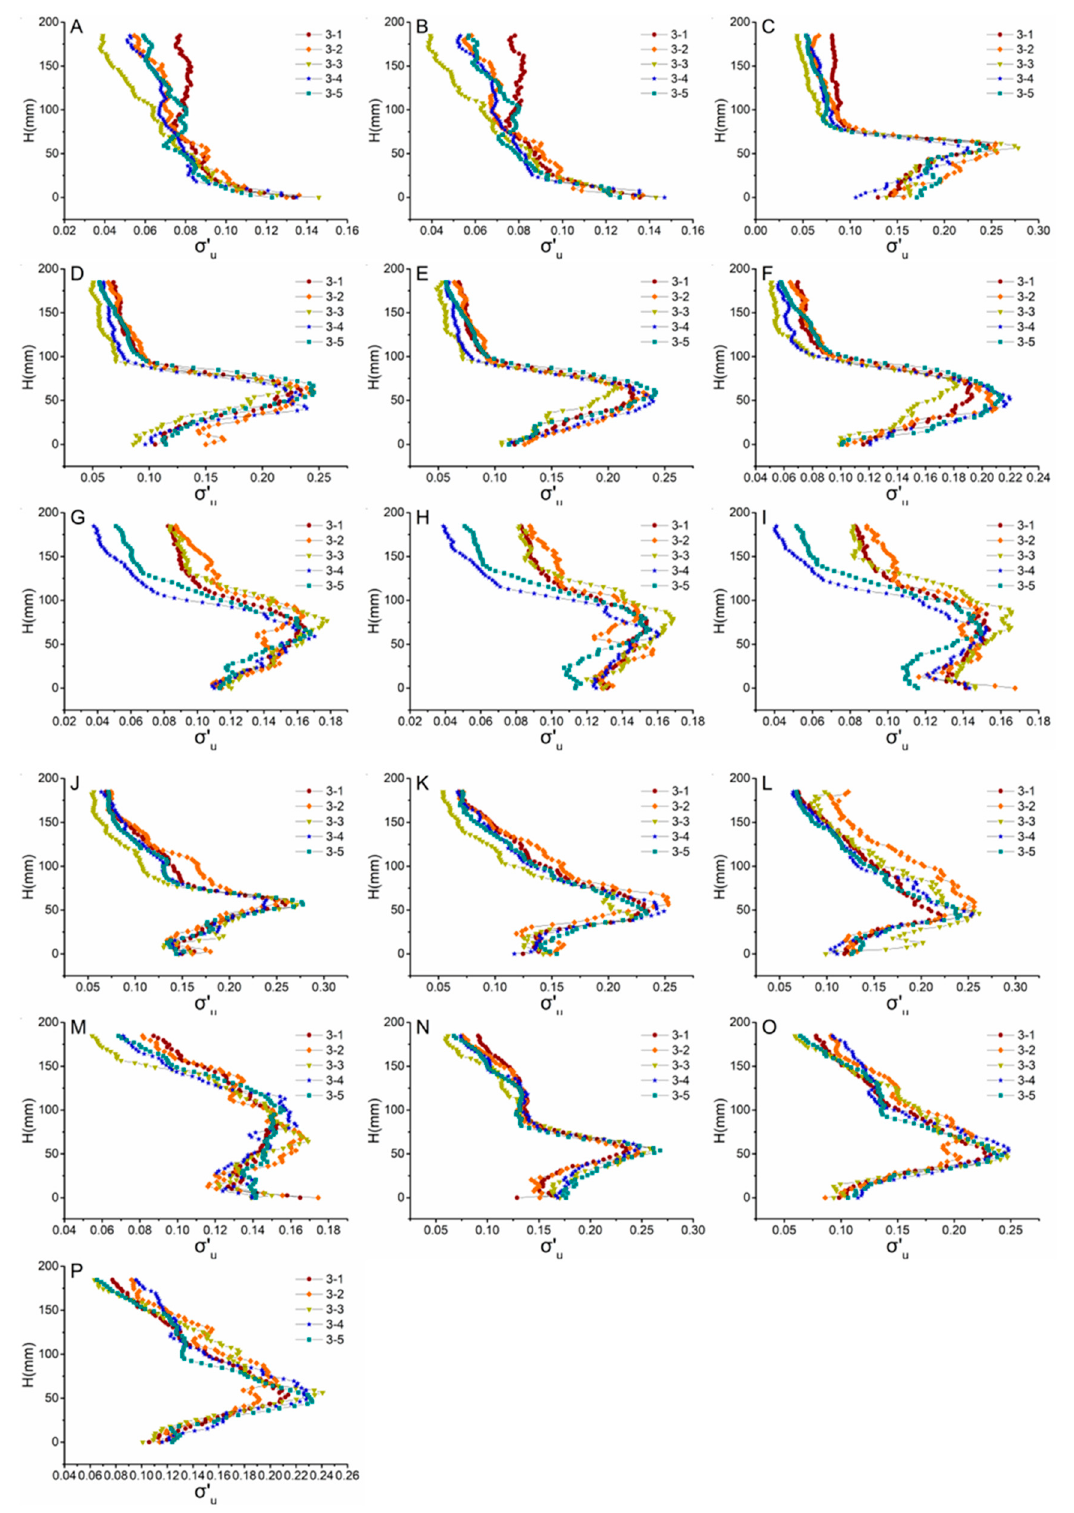
Figure 9. Longitudinal turbulence intensity for each section under geometrical configuration 3 and five different velocities tested. The subplots refers to the values measured at each of the 16 sections identified (A, B, C, D, E, F, G, H, I, J, K, L, M, N, O, P).